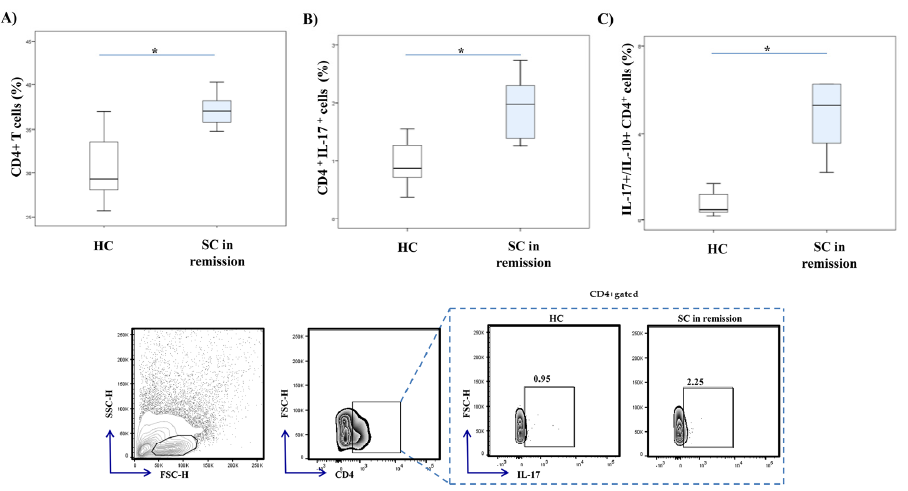
Figure 3. IL-17 and IL-10 production in peripheral blood CD4 + Th cells. Percentages and cytokine production of peripheral blood CD4 + cells were examined by flow cytometry. The graph and representative FACS plots display the percentage of CD4 + cells, IL-17 producing CD4 + cells and IL-17 + / IL-10 + CD4 + cells ratio in peripheral blood of patients with SC in remission and healthy controls, respectively. The Student’s t or Mann–Whitney U test was applied to evaluate statistically significant di ff erences between two groups, * p < 0.05. Higher percentage of CD4 + T cells was measured in the peripheral blood of SC in remission patients in comparison to healthy individuals ( A ). The percentage of CD4 + T cells that produce IL-17 was significantly increased in SC in remission vs. HC group ( B ). The ratio of IL-17 and IL-10 producing CD4 + T cells was significantly higher